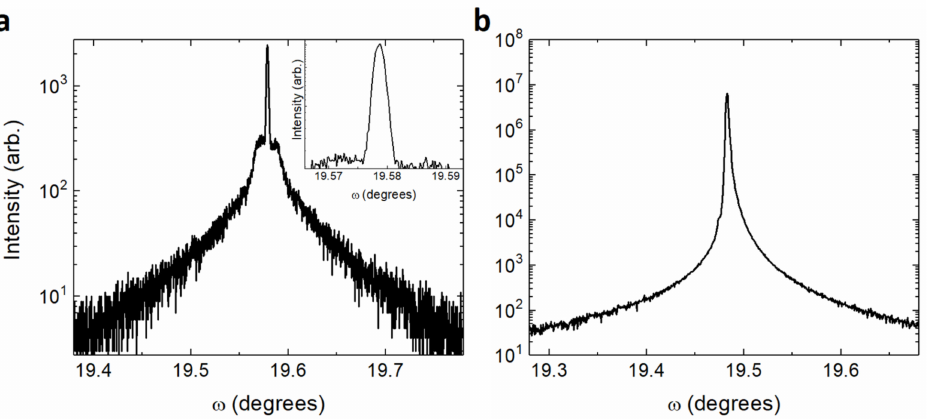
Figure 1. ( a ) X-ray diffraction rocking curve of epitaxial LN grown on sapphire via molecular beam epitaxy [77], with an 8.6 arcsec FWHM indicating a high-quality crystal strained to the sapphire substrate. The inset shows a well-resolved, narrow peak. ( b ) X-ray diffraction rocking curve of a bulk-grown LN wafer, with an FWHM of 10.4